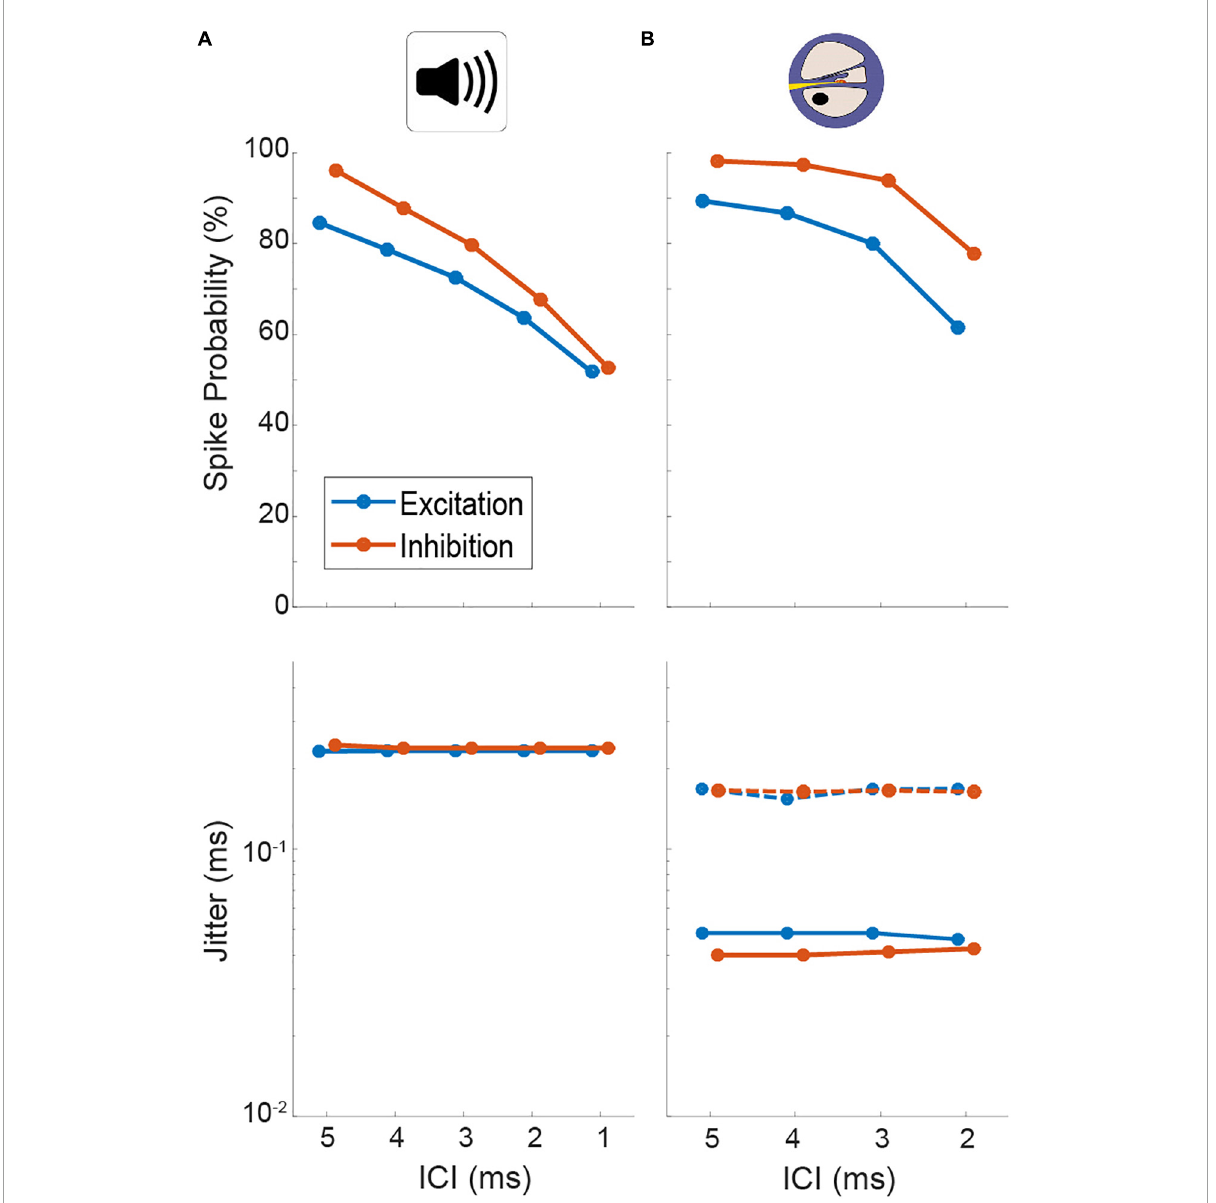
FIGURE4 Quantification of spiking probability (upper row) and precision (lower row) of model excitatory and inhibitory inputs to lateral superior olive (LSO) [corresponding to antero-ventral cochlear nucleus (AVCN) and medial nucleus of the trapezoid body (MNTB), respectively] in response to acoustic (A) and electrical (B) click train stimulation. Plotted are medians and 95% confidence intervals. Dotted lines represent model condition with auditory nerve (AN) jitter levels during electrical stimulation that resemble physiological acoustic jitter